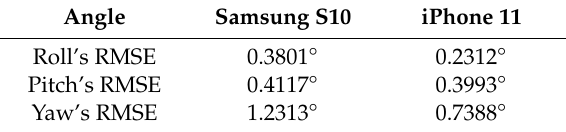
( b ) Figure 4. Estimated attitude before and after proposed method compared to the iPhone reference: ( a ) roll; ( b ) pitch.